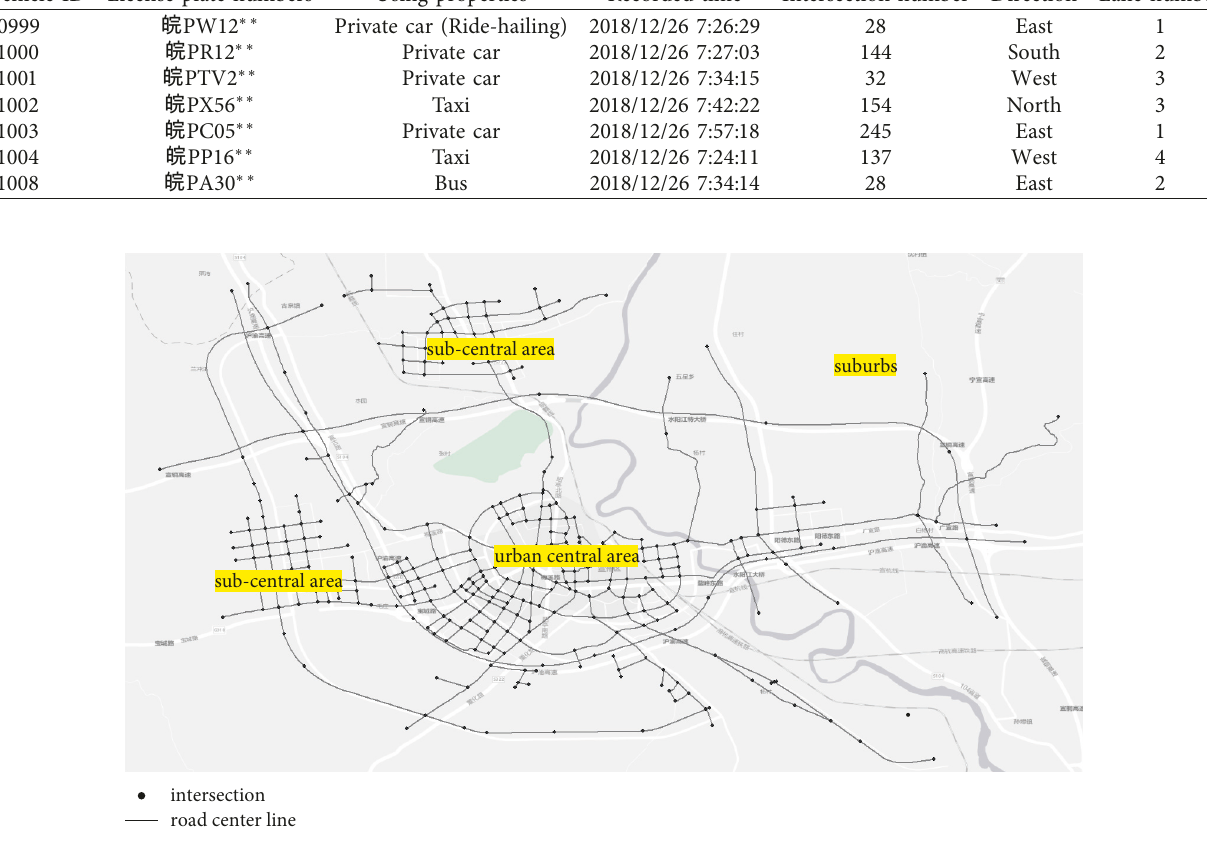
Figure 1: ArcGIS map of road network of Xuancheng. Table 4: Travel trajectory data of single vehicle.